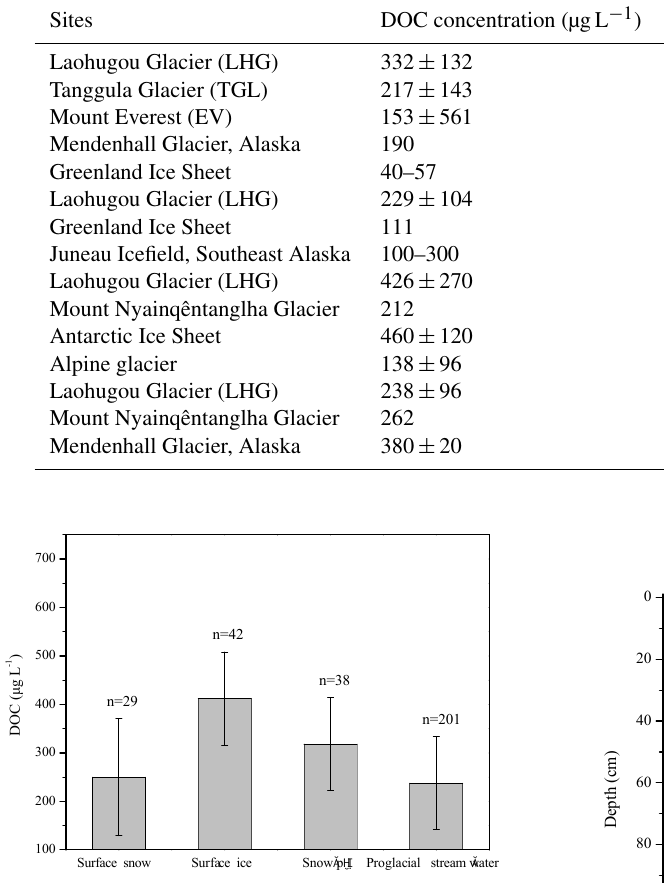
Figure 2. Average DOC concentrations of ice, snow and proglacial stream water for LHG.